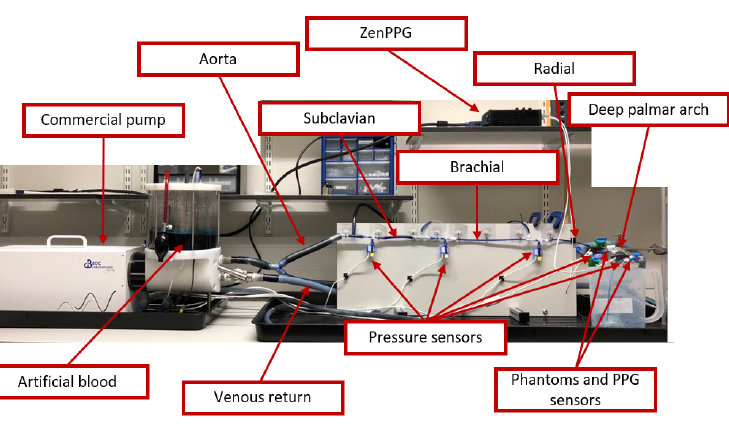
Figure 3. Constructed rig for the in-vitro experiment. This consisted of a commercial pump that replicates heart activity, tubing that mimics arteries and veins from the upper-body circulatory system, and a fluid that has similar optical properties as blood. Pressure sensors and photoplethysmographic (PPG) probes were used to measure the pressure in the tubes and the optical pulsatile signals from two developed tissue phantoms, that model the skin. PPG signals were acquired and processed using a custom-made system (ZenPPG) while pressure information was acquired directly from a data acquisition